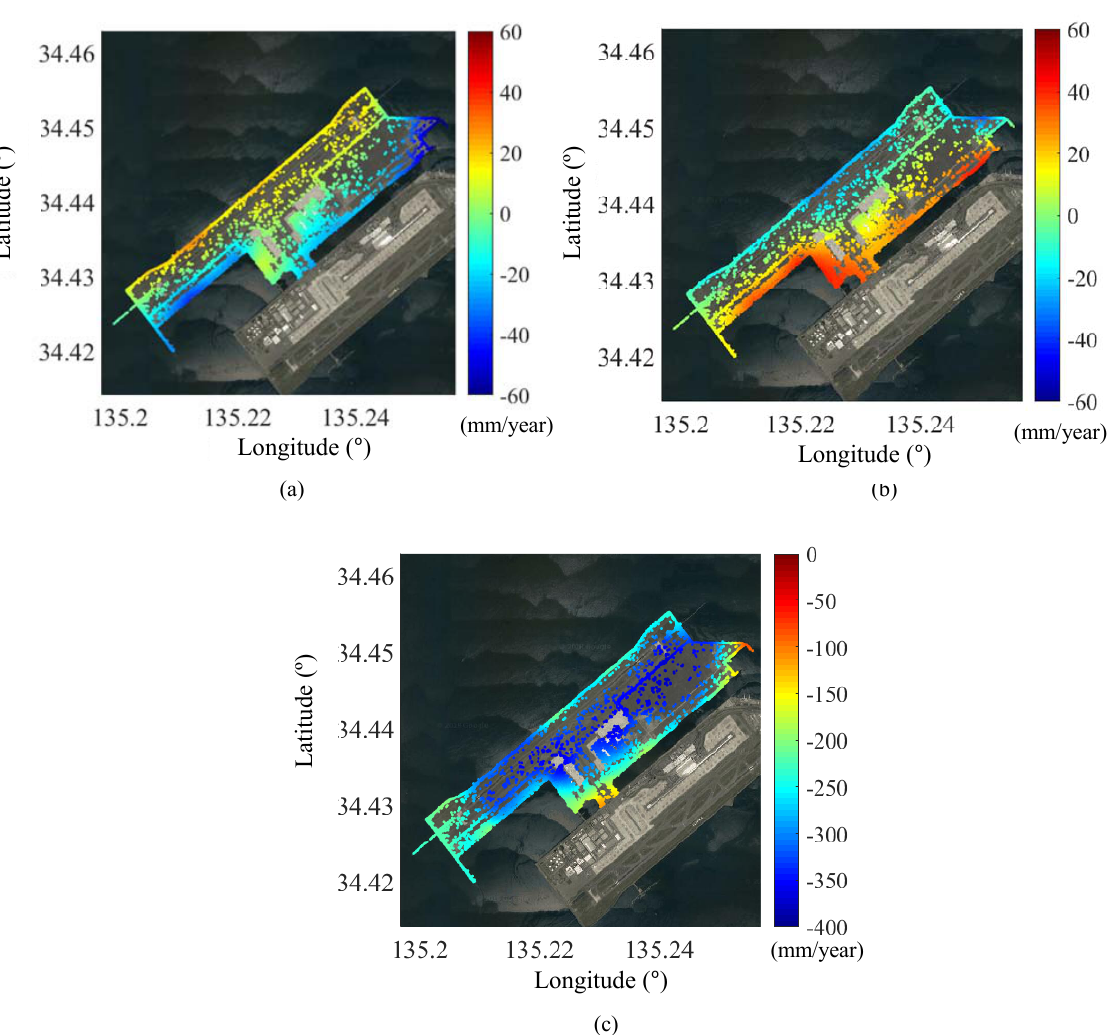
Figure 7. Interpolated results from GPS and leveling data: (a) east–west, (b) north–south, and (c) vertical displacement components. Velocity is shown in mm/year. Map data ©2020 Google, ZENRIN